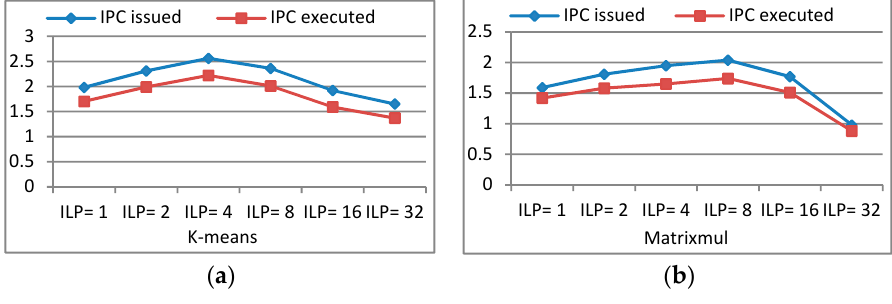
Figure 12. IPC issued and executed behaviors: ( a ) IPC of K-means; ( b ) IPC of Matrixmul.